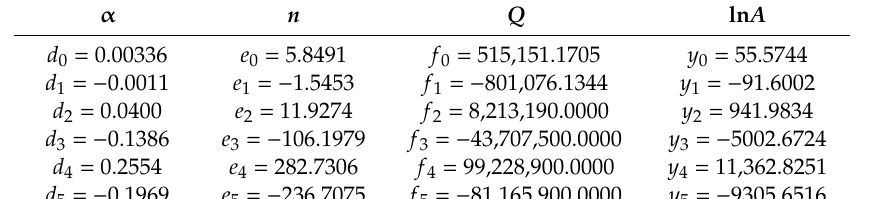
Figure 8. The material constants that vary with the strain: ( a ) α , ( b ) n , ( c ) ln A , and ( d ) Q . Table 4. The resulting fitting coefficients of α , n , ln A , and Q of as ‐ printed Ti–6Al–4V alloy.